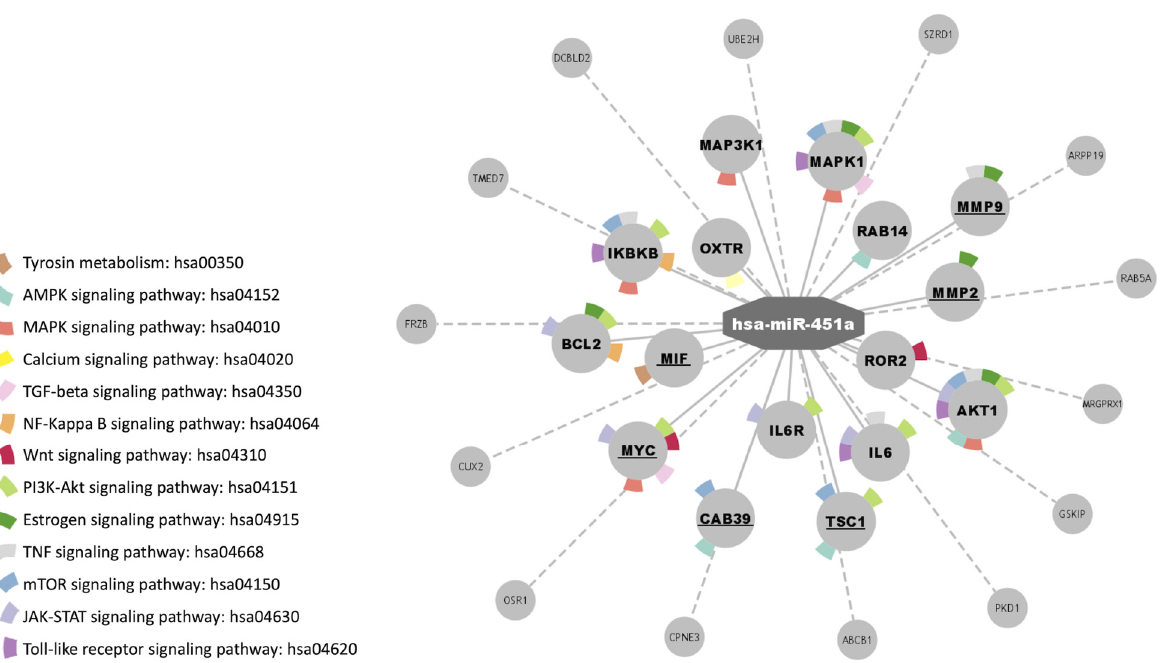
Figure 5. MiRNA-genes-pathways network denoting the relationships between miR-451a, validated target genes (dotted lines), and those related to KEGG pathways (solid lines), created in Cytoscape. Bold genes: belonging to KEGG pathways. Underlined genes: implicated in AF.